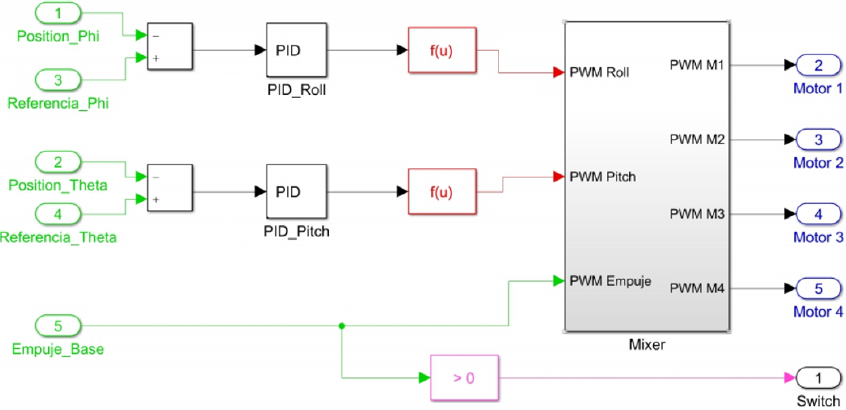
Figure 21. Block diagram in “Control algorithm” subsystem for PID controller